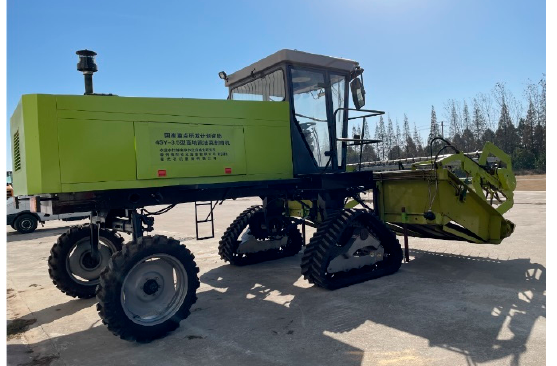
Figure 18. Running on the flat hard ground.